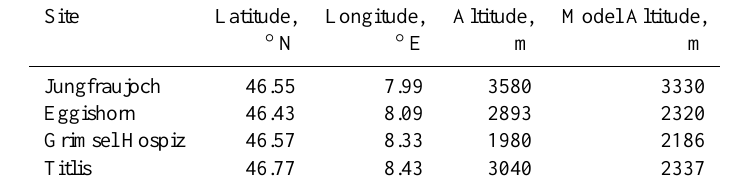
Table 2. Locations of four MeteoSwiss stations used to obtain meteorological data throughout the INUPIAQ campaign.